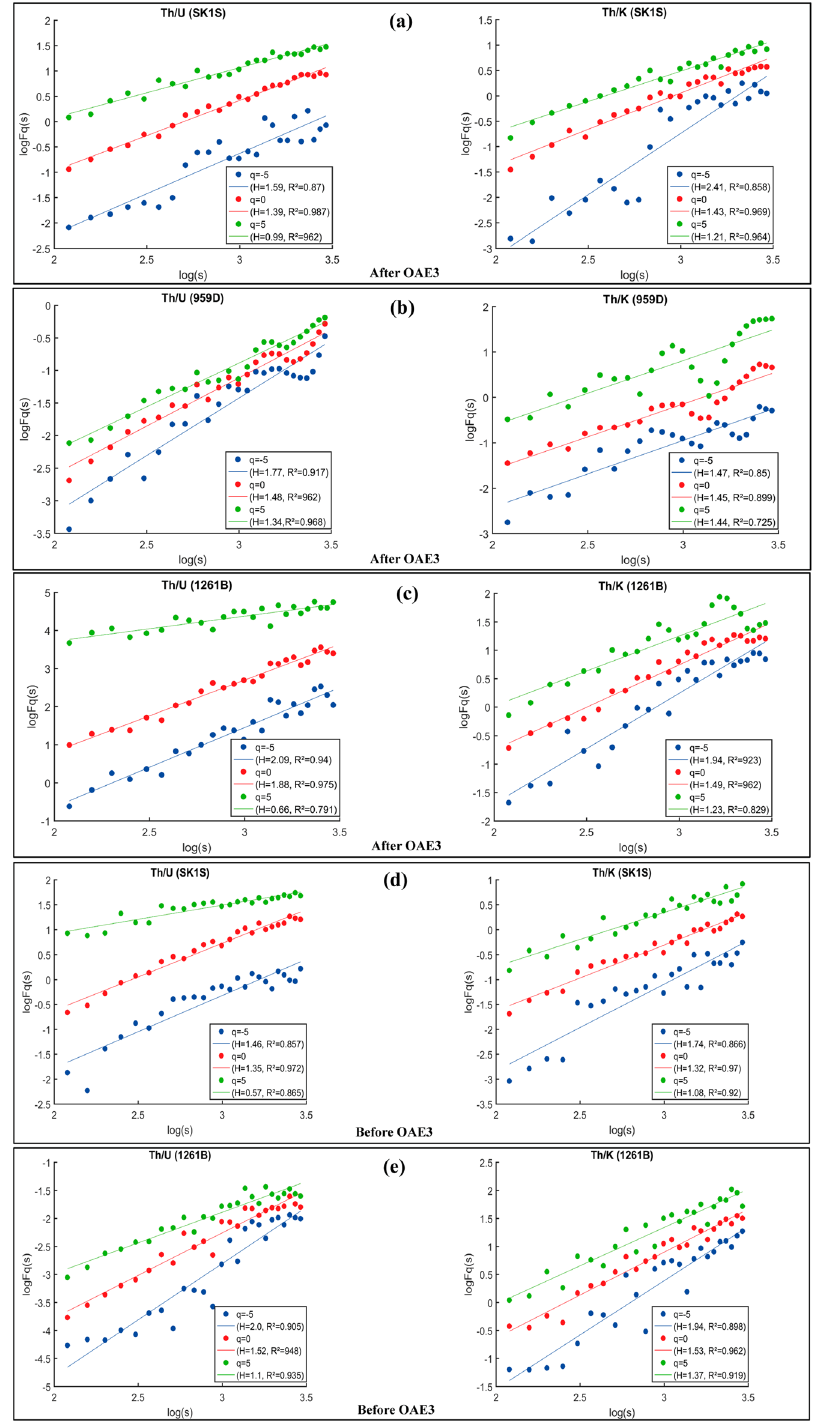
Figure 4. Scaling properties of log–log plots of the fluctuation function (Fq(s) versus q) of Th/U and Th/K ratios before and after the OAE3 interval in: ( a , d ) SLB (borehole south of the Chinese Continental Scientific Drilling Project: SK1S), ( b ) DIB (hole 959D of ODP Leg 159) and ( c , e ) DR (hole 1261B of leg 207); and their associated regression